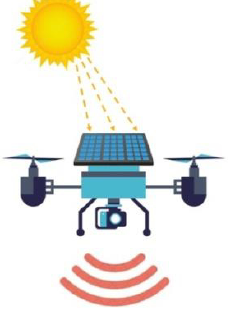
Fig 18. UAV in LOS communication